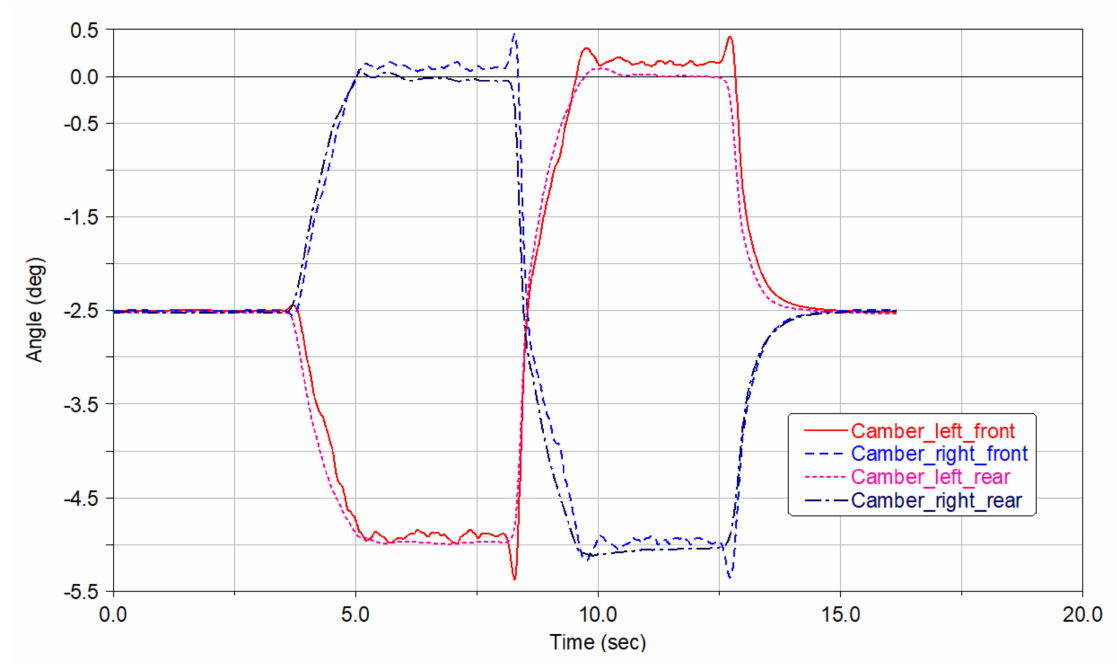
Figure 20. Skidpad Event-Tire camber angles, optimized